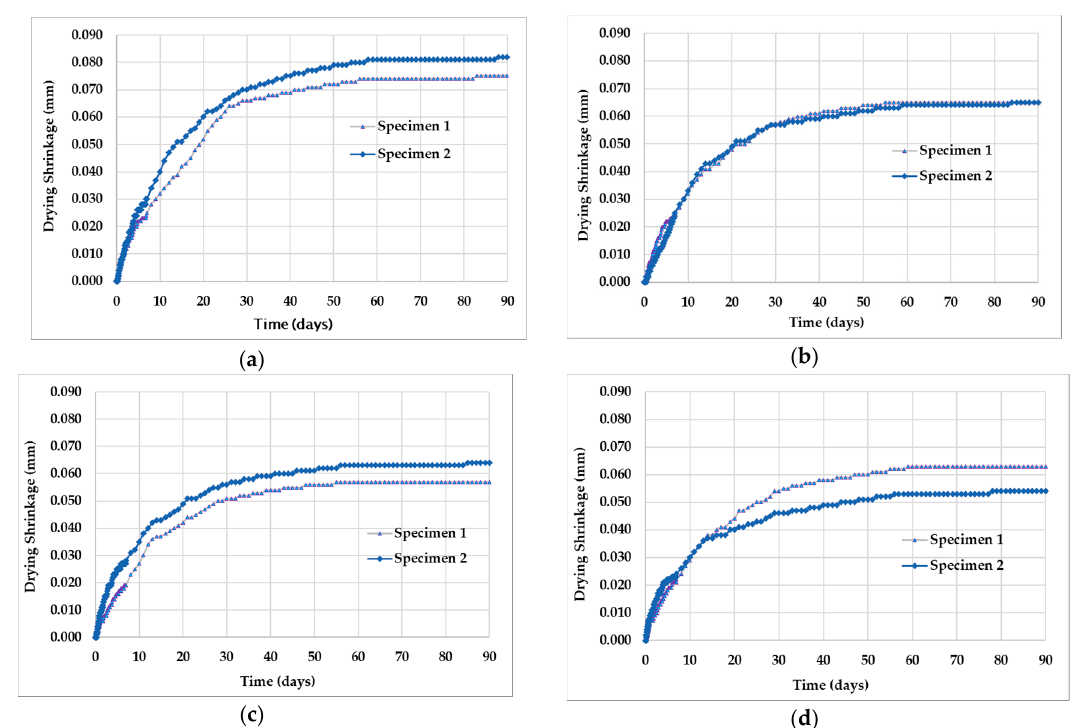
Figure 4. Drying shrinkage versus age of concrete specimen: ( a ) without calcium stearate (SCS0); ( b ) with calcium stearate 0.1% (SCS1); ( c ) with calcium stearate 0.2% (SCS2); ( d ) with calcium stearate 0.3% (SCS3).